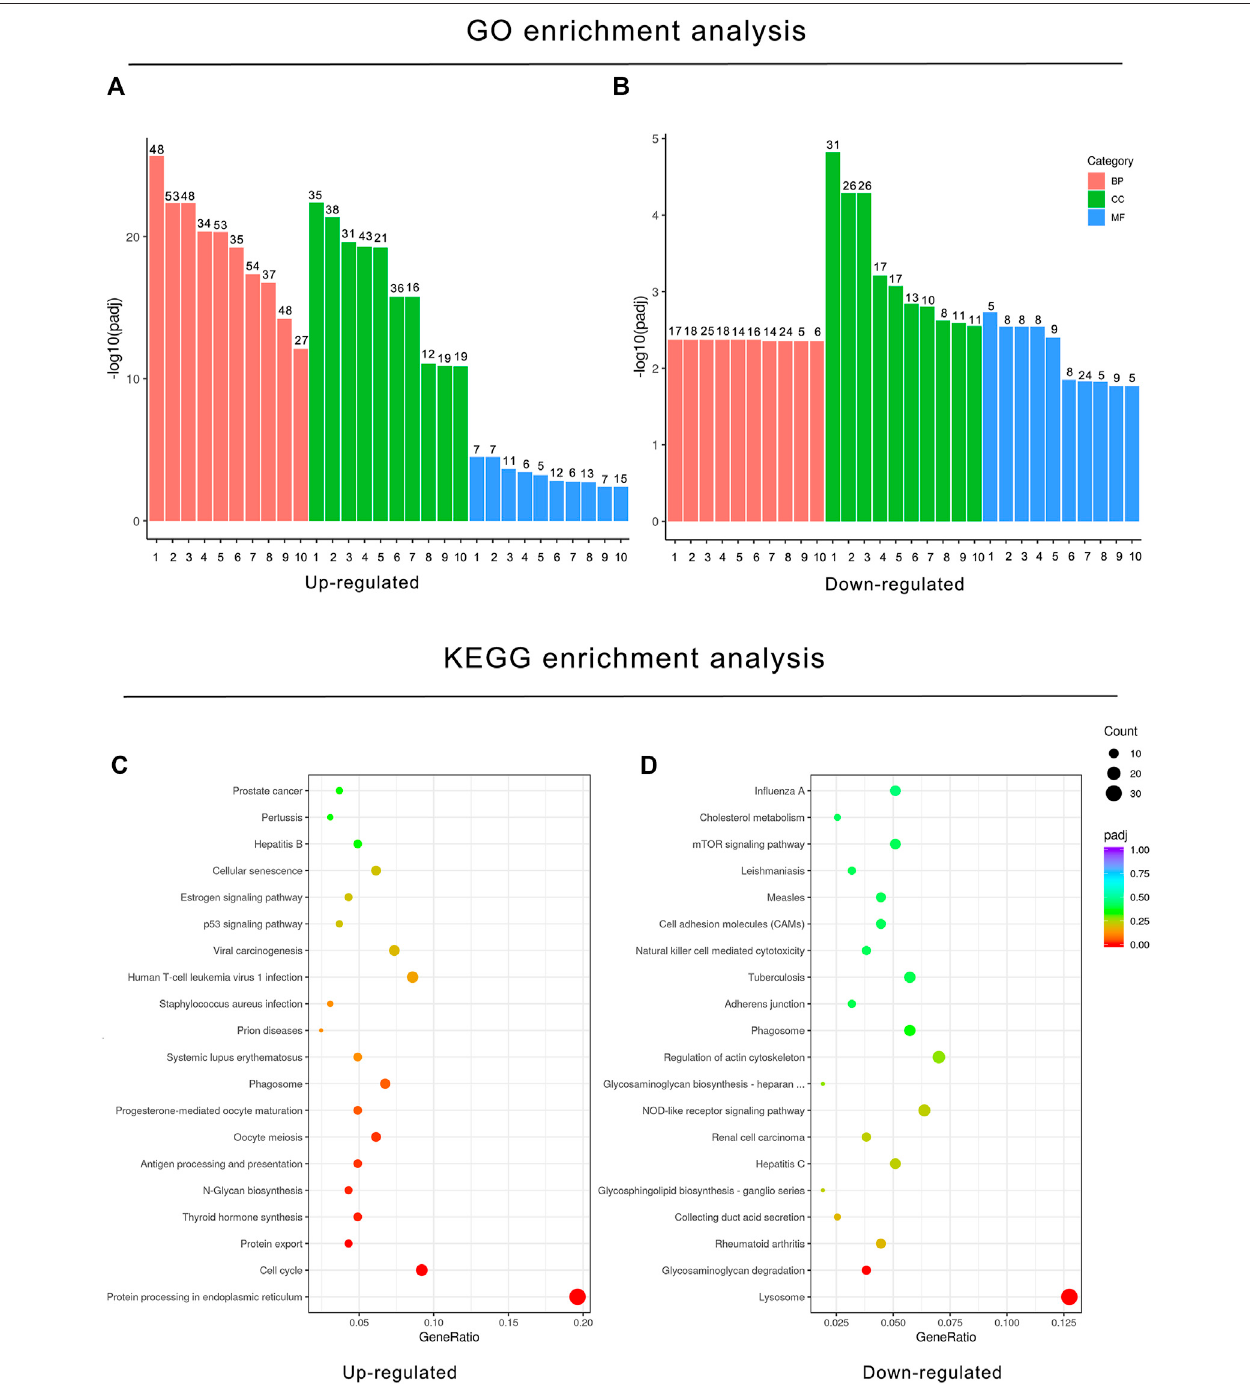
FIGURE 4 | Functional enrichment analysis of DEGs based on the GO annotation category and KEGG pathway category. GO enrichment analysis histogram. X -axis: theserialnumberofGOTerm (see SupplementaryTablesS1and S2 forfunctiondescription corresponding toGOenrichment analysis); Y -axis: thesigni fi cant difference of GOenrichmentbetween thecontrolgroup and BPF treatment group ( − log10 p value). (A) GOenrichmentanalysishistogram ofupregulatedDEGs. (B) GO enrichment analysis histogram of downregulated DEGs. (C) KEGG bubble charts of upregulated DEGs (C) and downregulated DEGs (D) . The size of dots represents the number of genes annotated to GO enrichment or the KEGG pathway, and the color from red to purple represents the signi fi cance of enrichment.